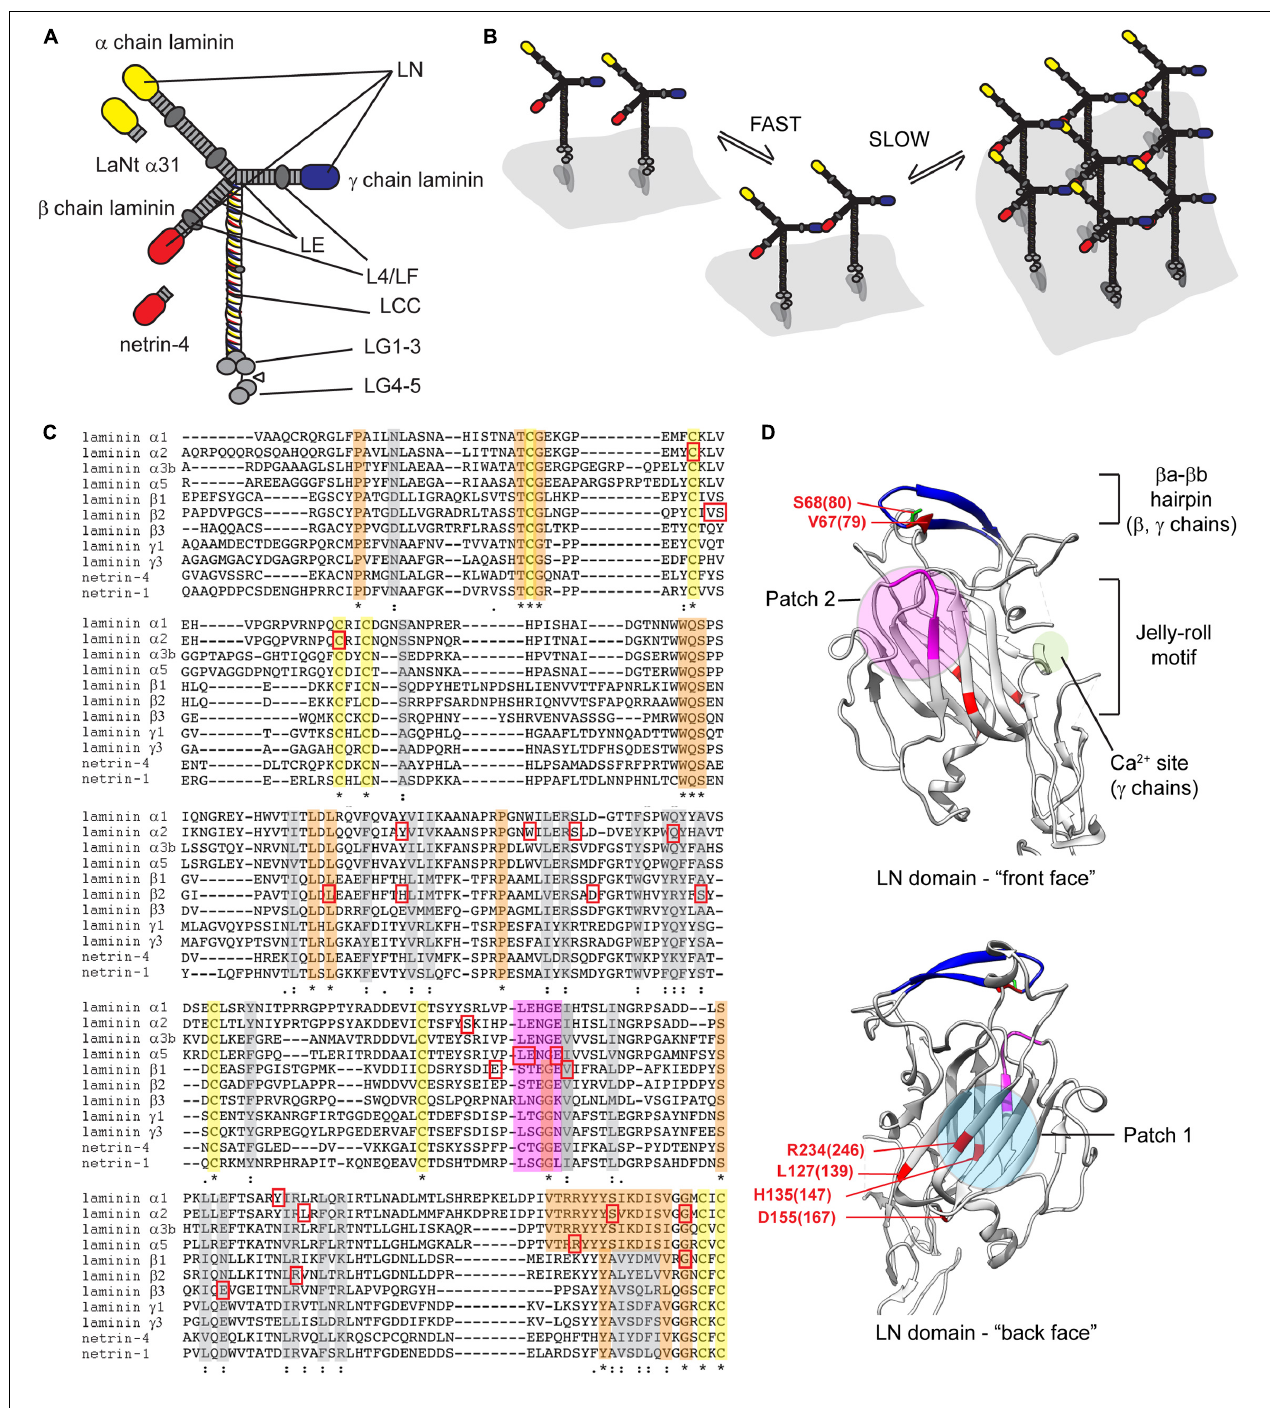
FIGURE 1 | (A) Diagrammatic representation of archetypal LM structure. Yellow ovals α LN domains, red = β LN domains and blue = γ LN domains. LE, laminin-type EGF-like repeat; LCC, laminin coiled coil domain; LG, laminin globular domains. (B) Two-step laminin network assembly. Secreted LMs associated with cell surface receptors, predominantly via their LG domain regions, β − γ LN domain interactions are then facilitated in a reaction with rapid on/off kinetics, then in the propagation step β − γ interactions are stabilized via incorporation of an α -chain leading to a stable cell-associated network. (C) Sequence alignments of LN domains from human laminin chains, netrin-1 and netrin-4. Yellow, orange, and gray highlights indicated conserved cysteines, fully conserved residues, or partially conserved residues. Magenta highlight identifies LENGE region. Red squares indicate pathogenic missense mutations. (D) Crystal structures of LN domains. View of the front and back face of the β 1 chain is shown with features of conserved patches involved in LN-interaction (patch 2) and required for domain folding (patch 1). Amino acids associated Pierson syndrome mutations are indicated numbered based on LM β 1 with LM β 2 equivalent in parenthesis. Crystal structures derived from Hussain et al. (2011) and Carafoli et al. (2012) rendered using UCSF chimera (Pettersen et al., 2004). * = conserved residue, : = conservation of residues with strongly similar properties, . = conservation of residues with weakly similar properties.